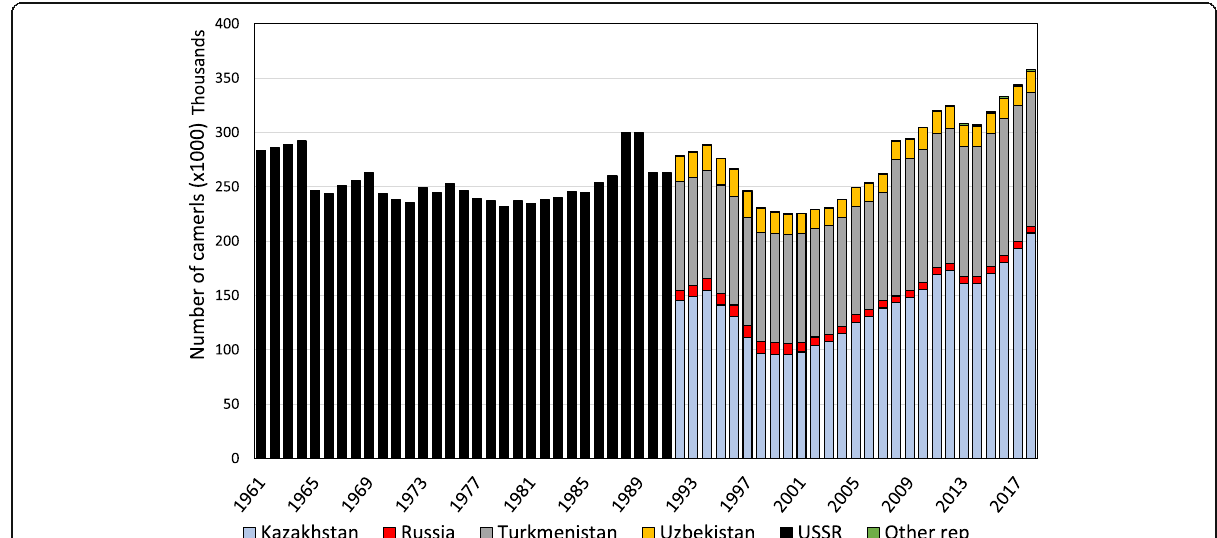
Fig. 16 Changes in camel stock in USSR (1961 – 1991) and in the sum of new independent states (1992 – 2018) according to the FAOstat data